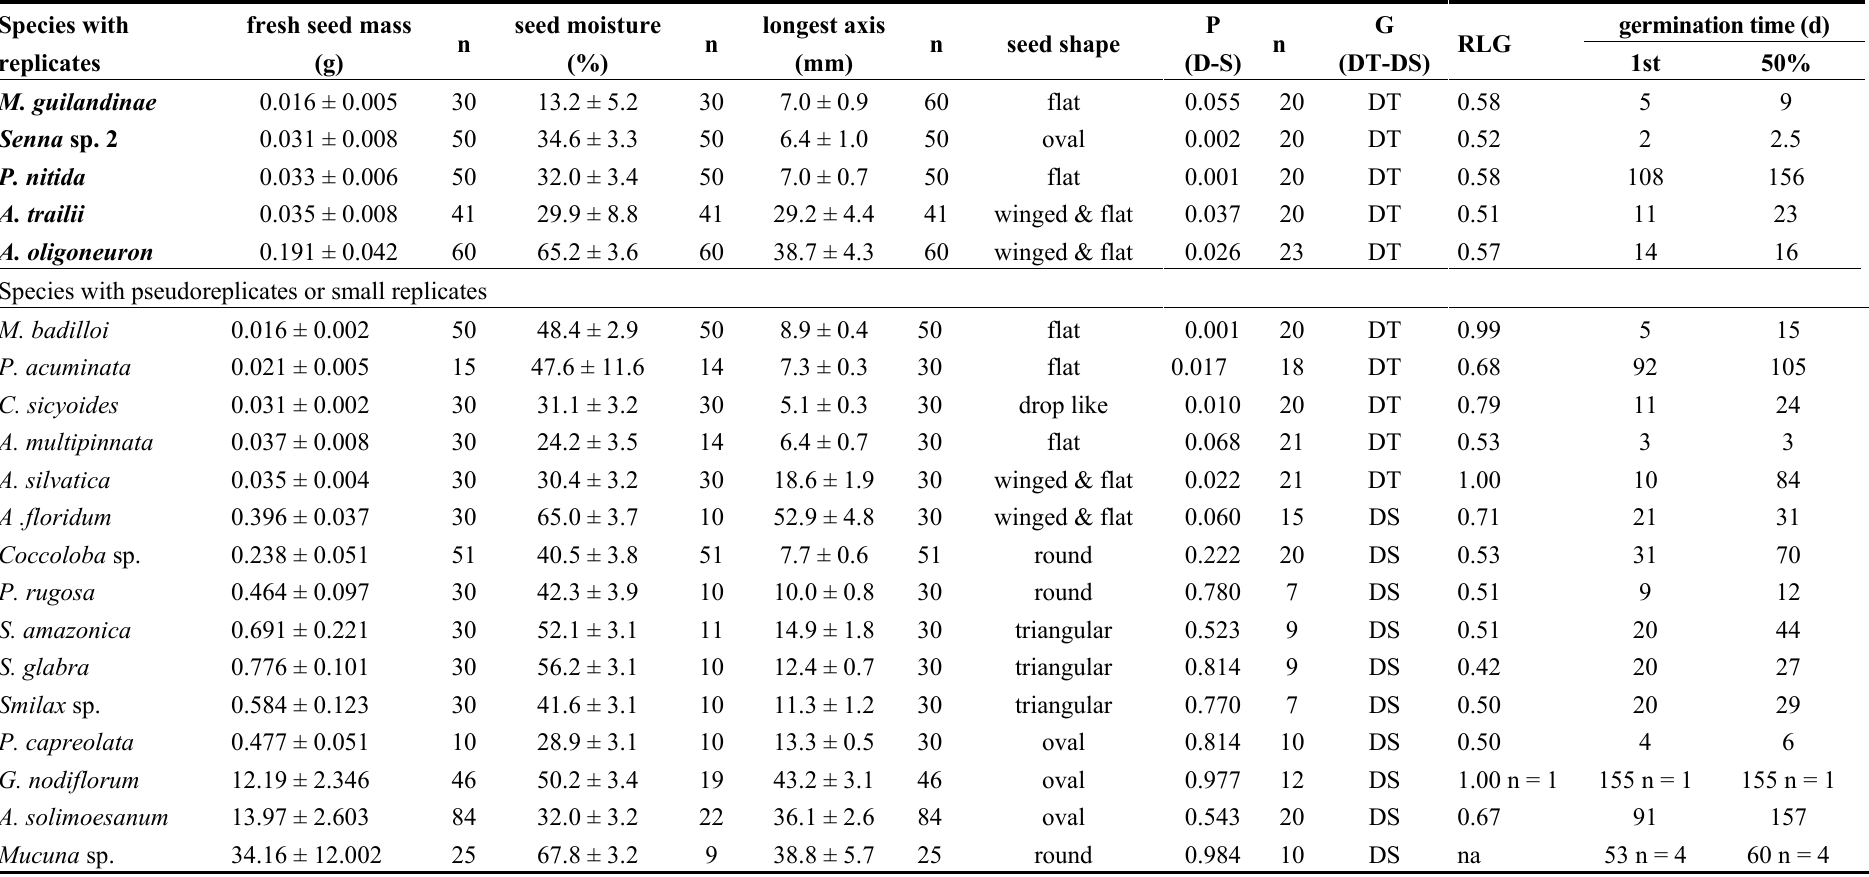
Table 2. Seed and germination characteristics of 20 liana species ordered by increasing dry seed